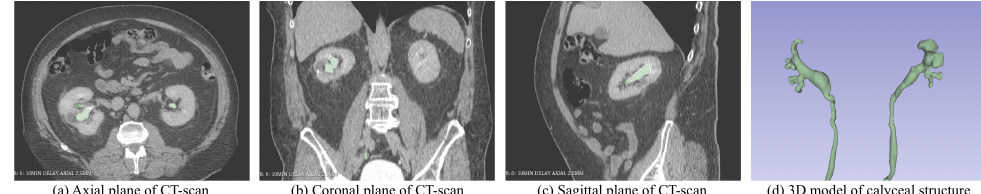
Figure 5. 3D model of the calyxial system within the kidney in ( d ) and overlayed onto the patient’s CT scans in ( a – c ), which are the axial, coronal, and sagittal planes of the CT scans,